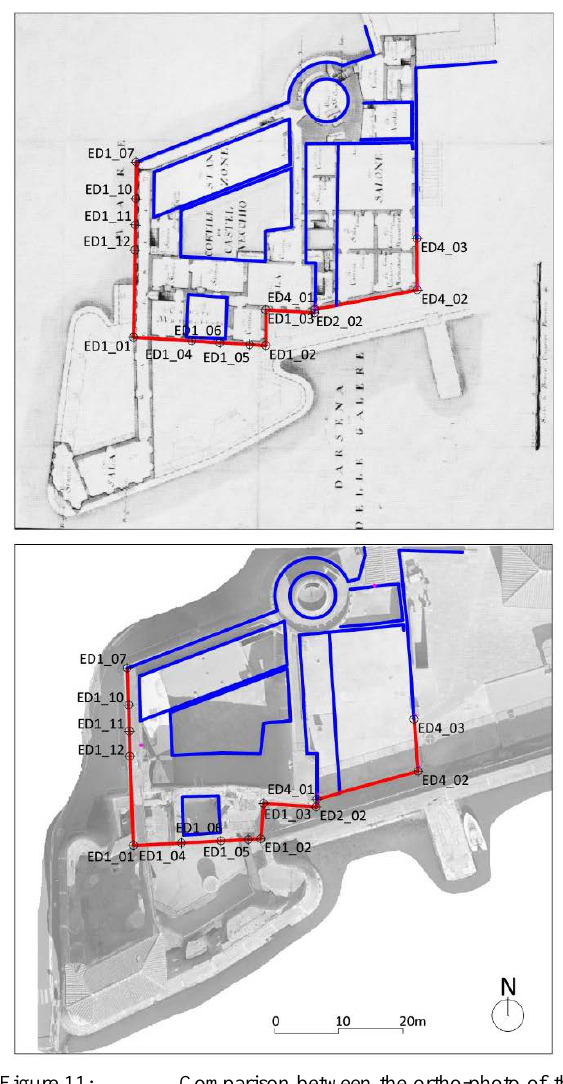
Figure 11: Comparison between the ortho-photo of the UAV model and a 17 th archive plan (fig. 3); in evidence, the planimetric print of